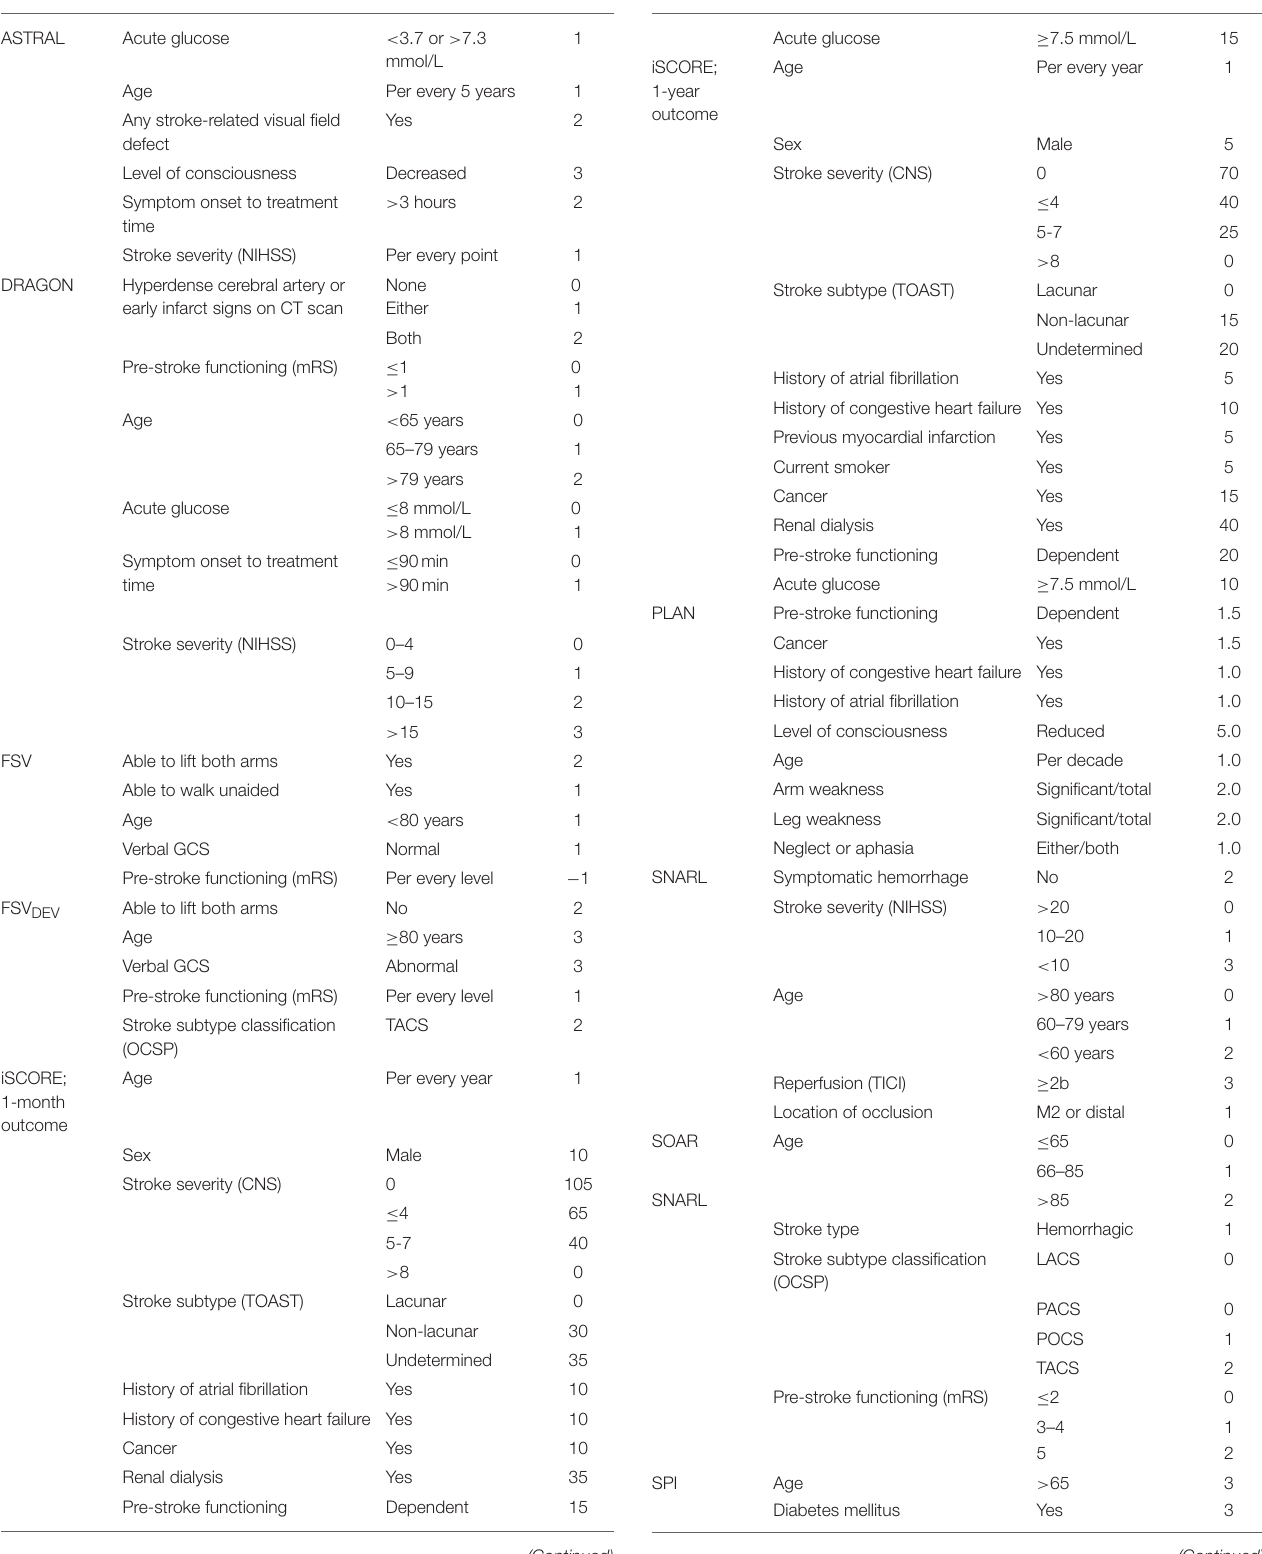
TABLE 4 | Scale variables and scoring